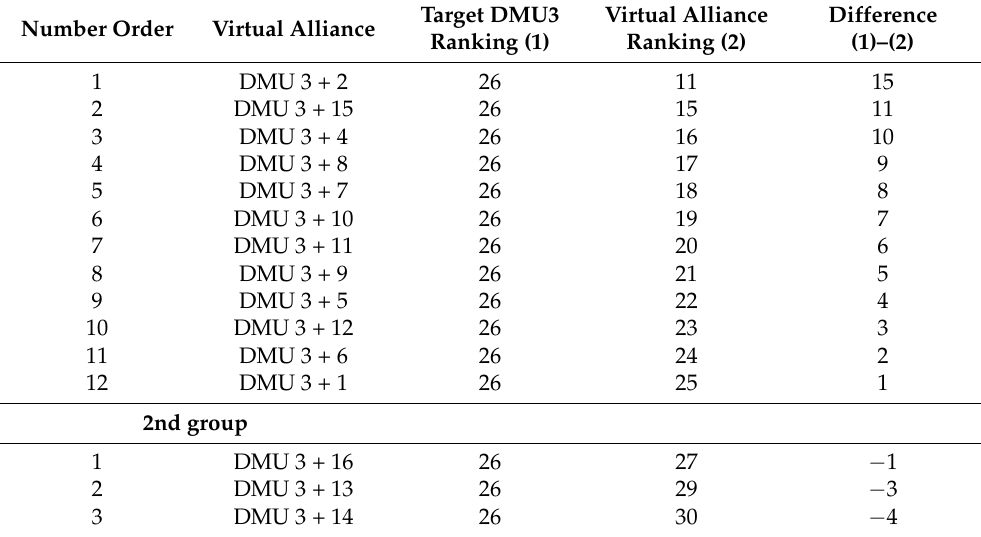
Table 12. The good and bad alliance